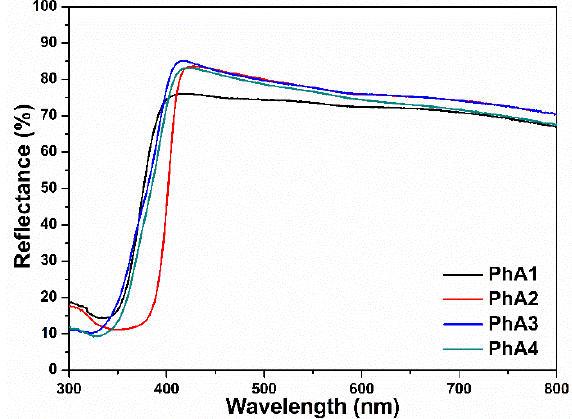
Figure 9. UV-Vis reflectance spectra of the TiO 2 photoanodes.